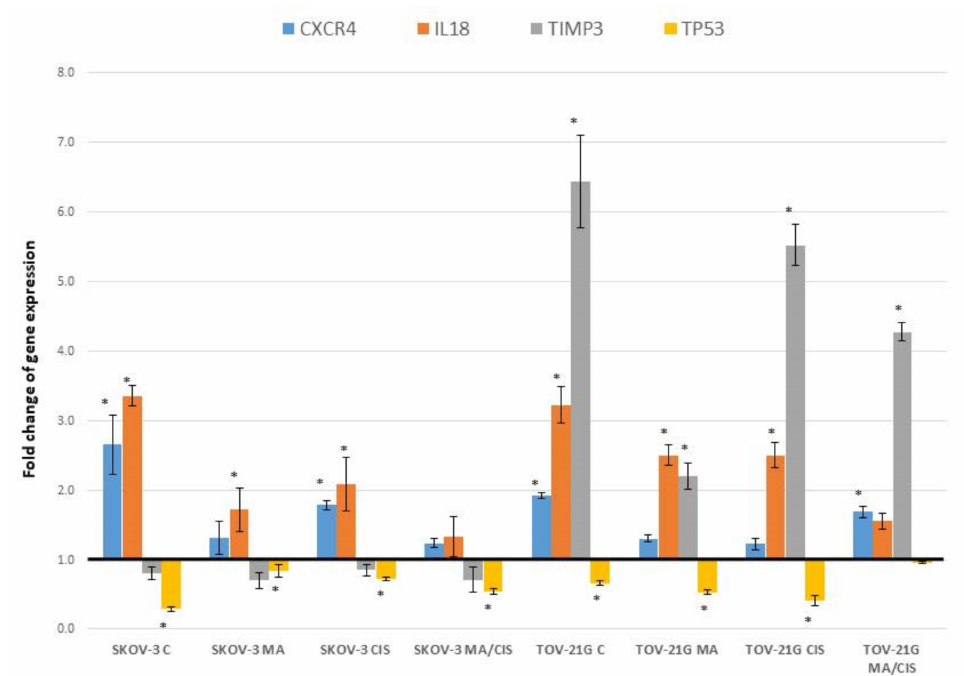
Figure 6. Effect of exosomes derived from SKOV-3 and TOV-21G cells (untreated with drugs, α - mangostin and/or cisplatin-treated) on the expression of apoptosis markers in fibroblasts. The data are shown as mean ± SD of triplicate experiments, statistically significant results * ( p <